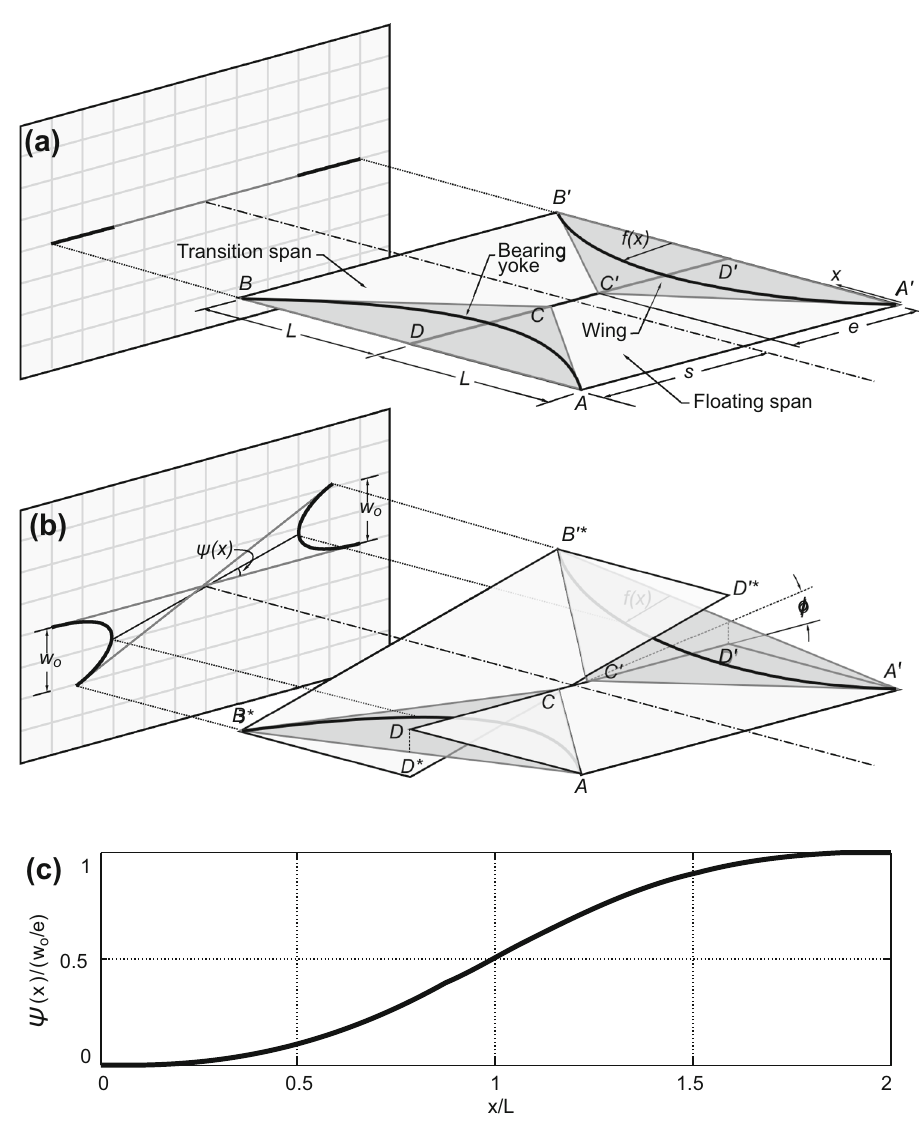
Fig. 9 Geometry for analysis of roll motions, ( a ) undeformed, ( b ) deformed (rotations are greatly exaggerated), ( c ) roll angle over a CESuRa system with a circular